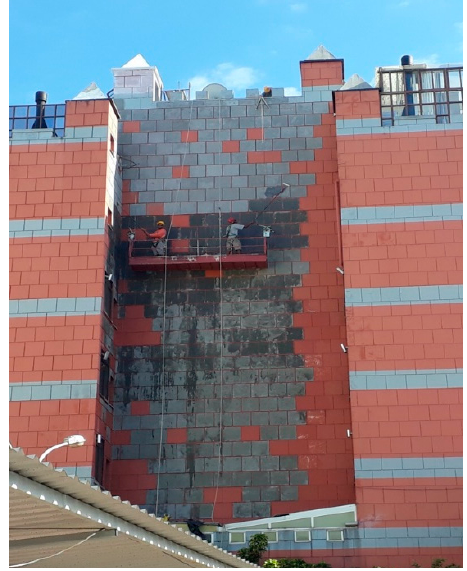
Figure 4. Crack sealing with adhesive mortar.